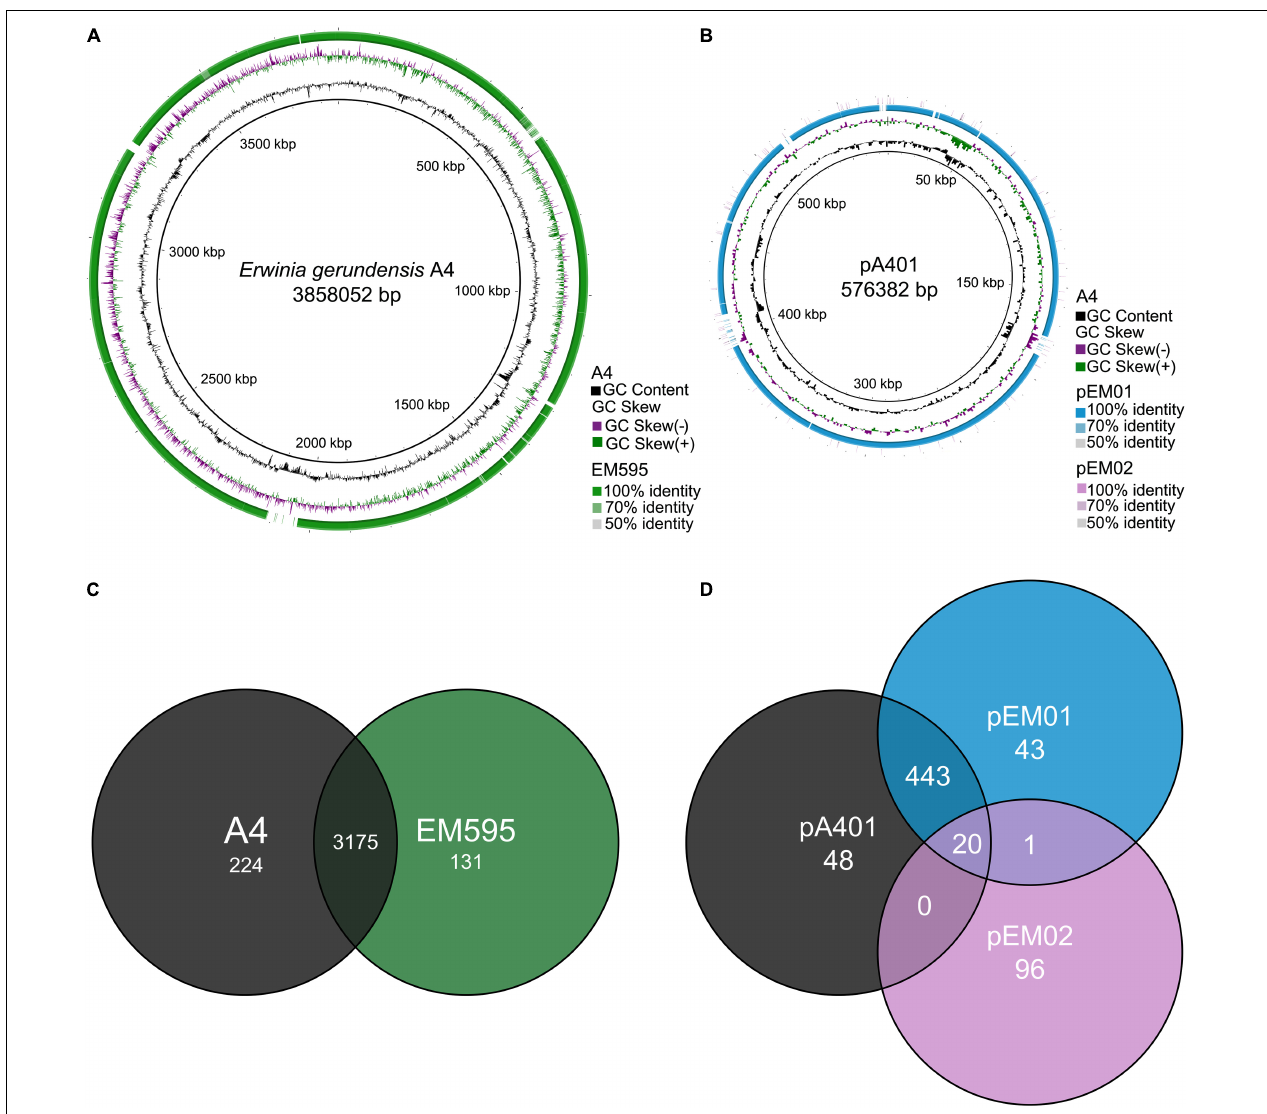
FIGURE 5 | Comparison between E. gerundensis strain A4 and EM595. (A,B) Circular comparisons between both genomes and plasmids. The inner black rings depict the coordinates in scale and total size of chromosome (A) and plasmid (B) of A4. Black histograms represent GC content, while green-purple histograms show GC deviations. Orthologous sequences are displayed with the percentage of similarity. (C,D) Venn diagrams of chromosomes and plasmids of both